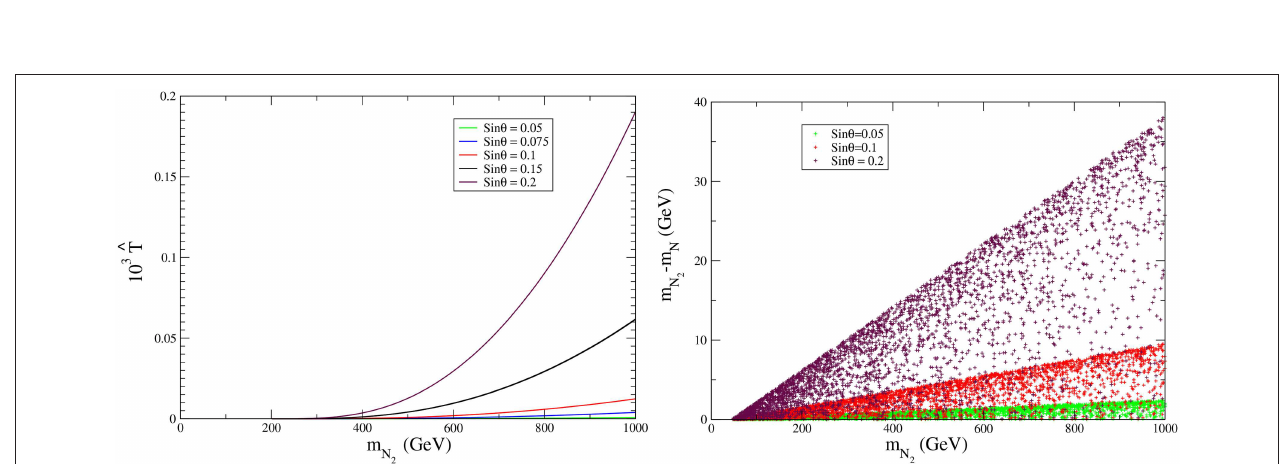
0.2 (Maroon color). In the right panel, allowed values of ˆ S is plotted in m N = 0.2 (Maroon color). =